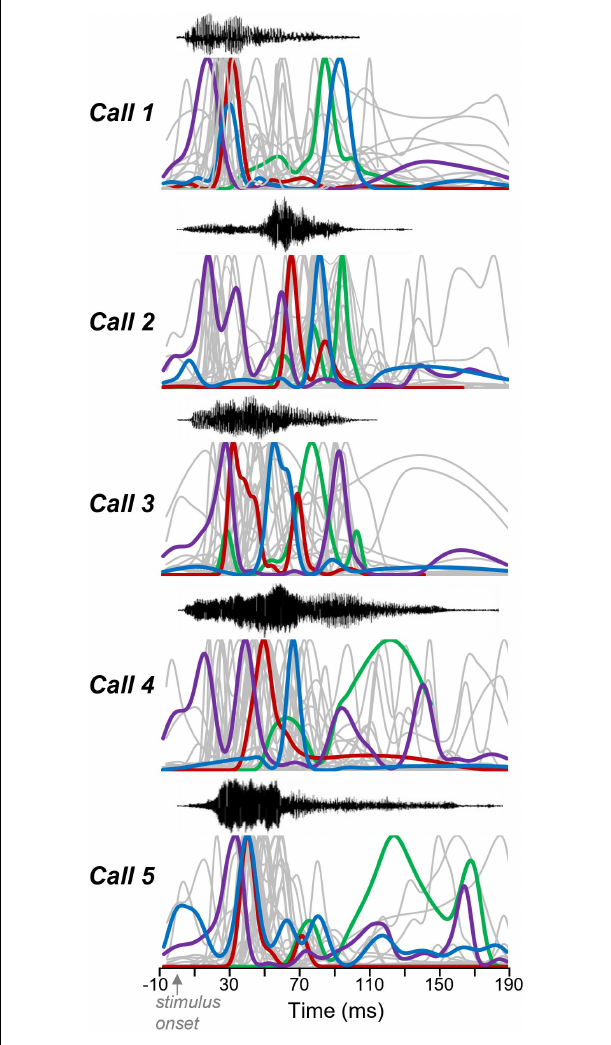
FIGURE 5 | Response features vary among neurons and calls. Oscillograms (top) and normalized spike density functions for 30 neurons across five calls. Specific colors represent spike density functions of single neurons with a range of peak response times. A given color represents responses of the same neuron across calls. Gray spike density functions are from the remaining 26